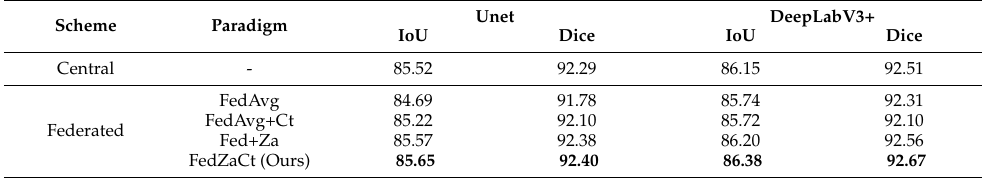
Table 2. Mean evaluation values of ten repeated experiments on the public HAM10000 dataset.